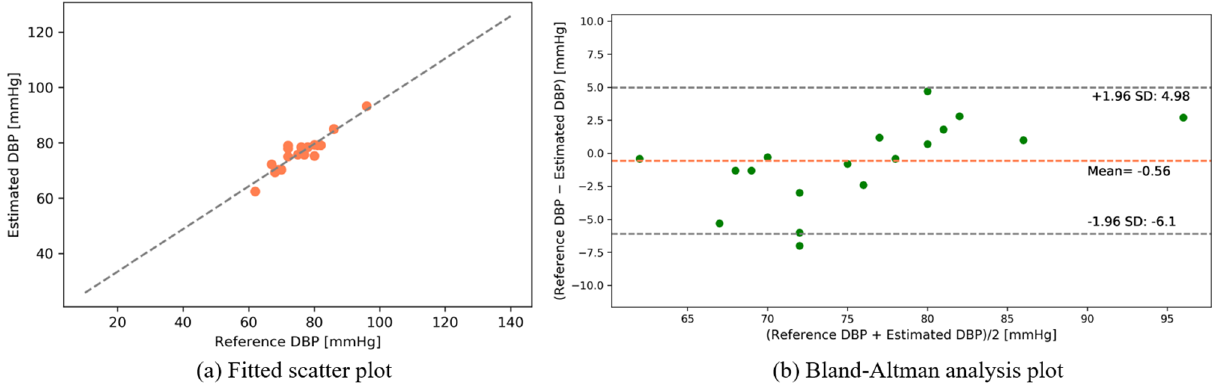
Figure 18. SBP estimation (self-made dataset).